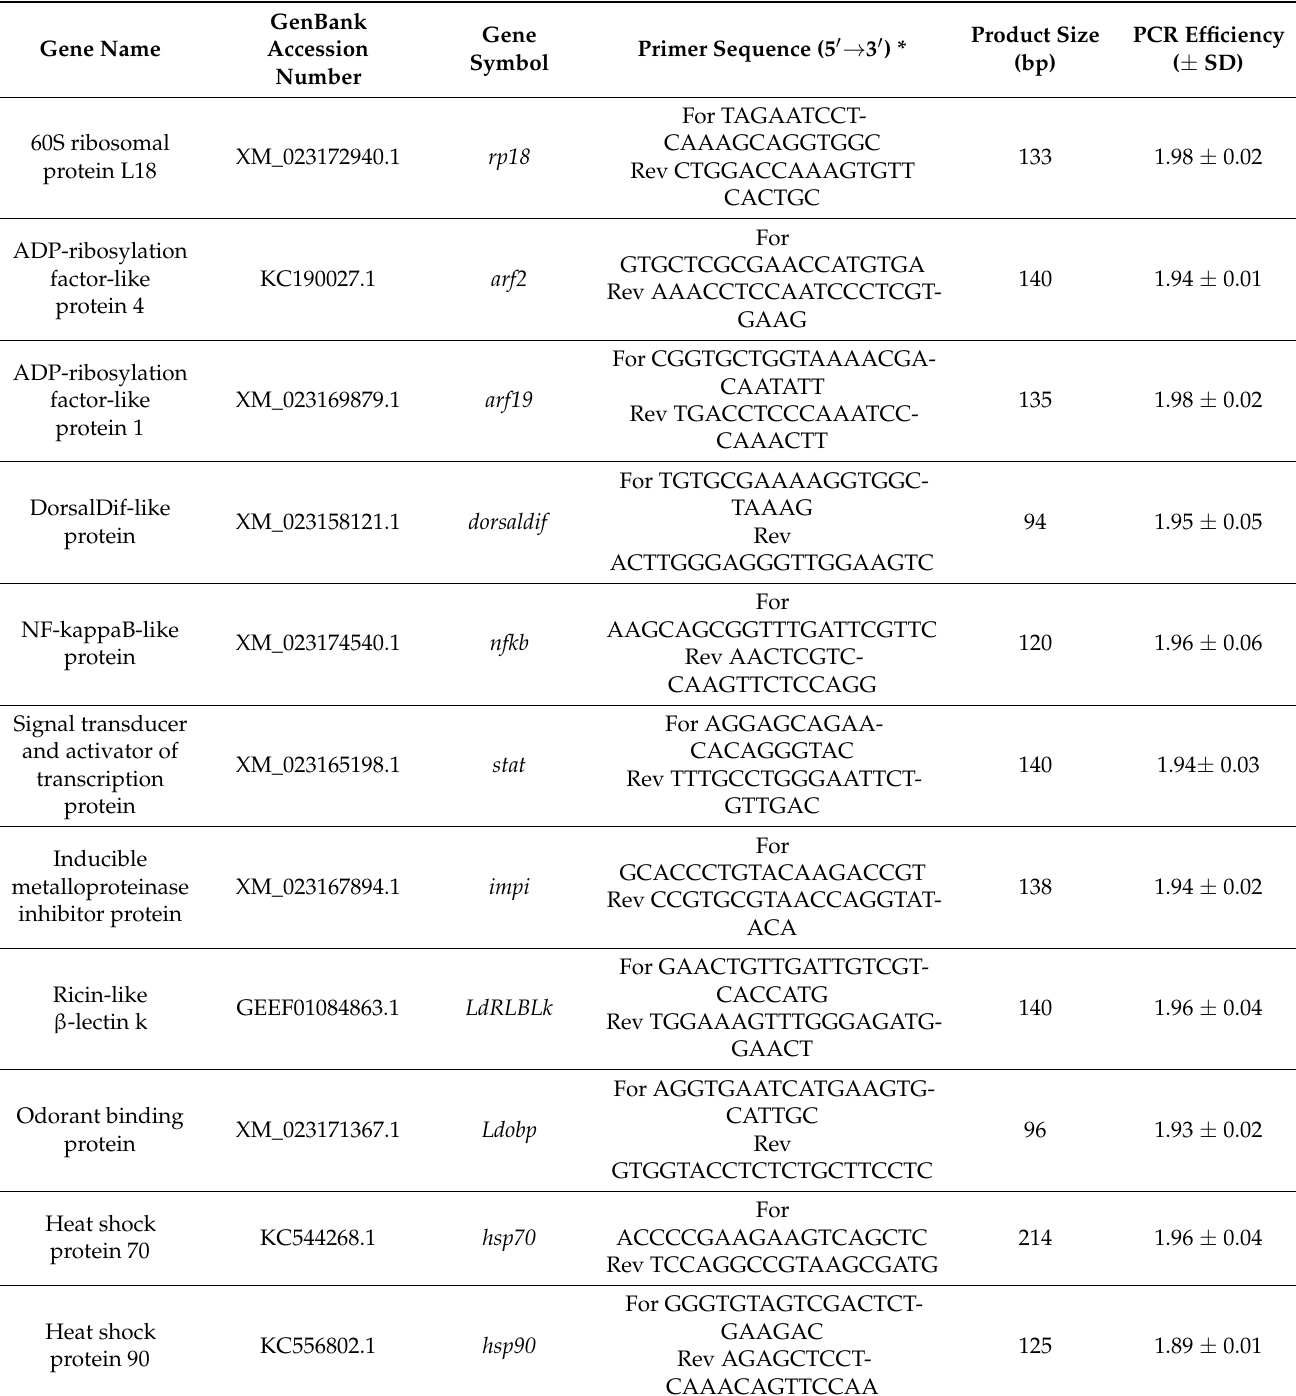
Table 1. The list and description of genes and primer sequences used in the